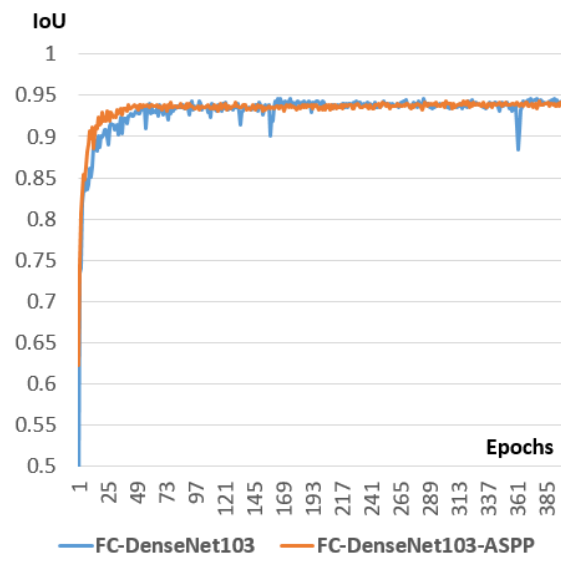
Figure 15. IoU after every epoch of the training before and after adding the ASPP block.